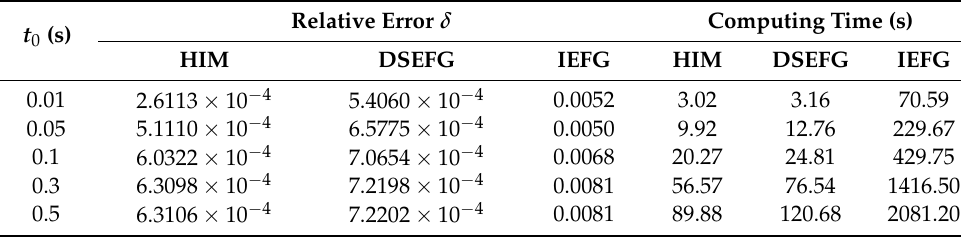
Table 3. Comparison of relative error and computing time when t 0 is different. t 0 (s)